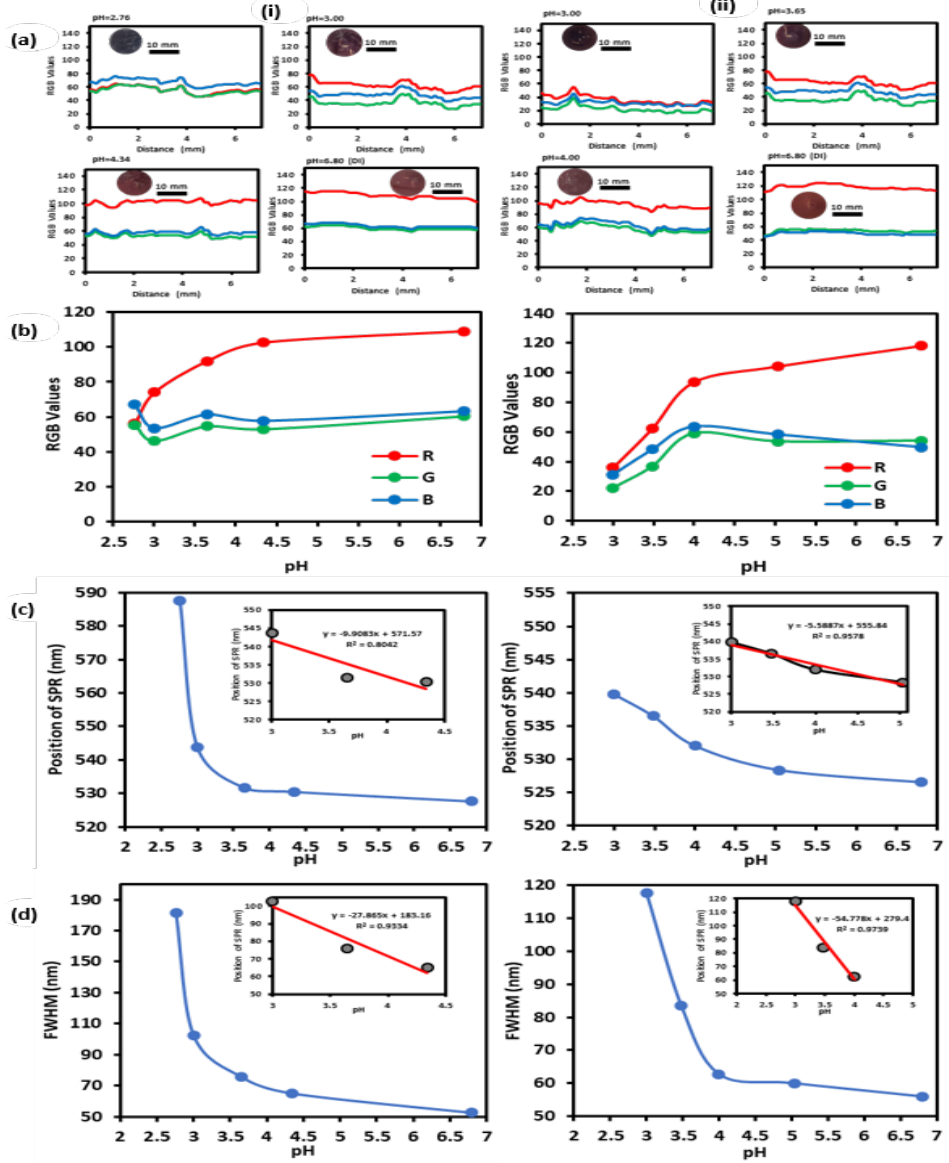
Figure 6. Analysis of the pH-responsiveness of GNPs-MPA doped ( i ) low and ( ii ) high concentrated gels. ( a ) RGB colorimetric analysis of the gel at different pHs using ImageJ. ( b ) RGB of the gel as a function of pH. ( c ) SPR’s position and ( d ) FWHM versus pH. Inset shows the gel’s linear behavior in the pH-responsive range (3 – 5).